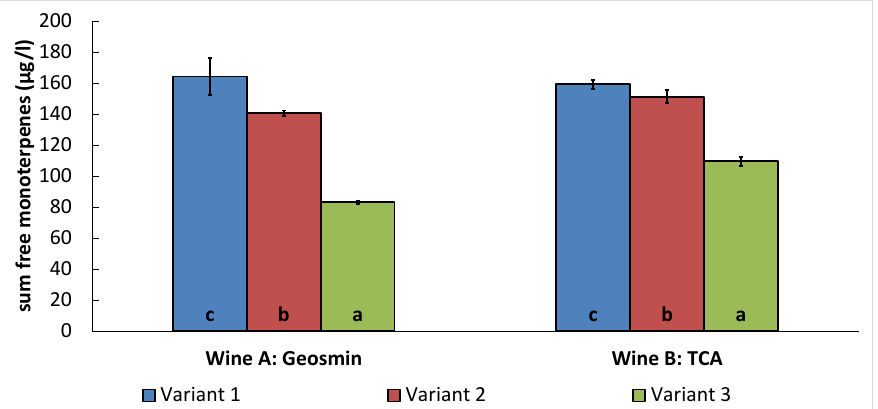
Figure 4. Loss of free monoterpenes by filtration with conventional EKS layers (variant 2) and Fibrafix ® TX layers (variant 3) compared with the control sample (variant 1) in the small-scale test significance test using simple ANOVA and post hoc test Tukey B test. Same letters mean no significant difference based on significance level p ≤ 0.05 with alphabetical order, starting with a (smallest value) to c (largest value).